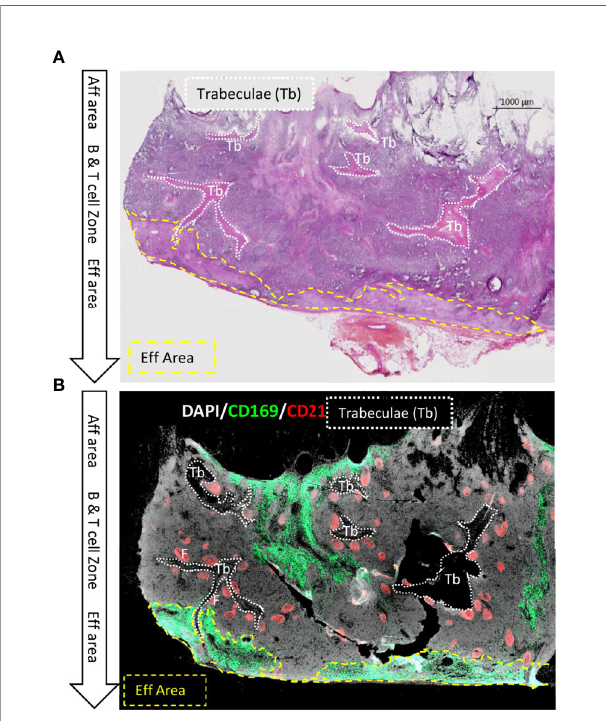
FIGURE 1 | Main features of swine inverted LN in HES and B cells/macrophage immuno fl uorescent staining on consecutive sections. Consecutive 10 µm thick sections of a tracheobronchial LN were stained using (A) HES or (B) anti-CD21 (red) and anti-CD169 (green) antibodies and DAPI nuclear staining. Dotted white lines delimited Trabeculae (Tb), dashed yellow lines delimited the efferent area (Eff Area). F: B cell Follicle. Aff area, Afferent area; Eff area, Efferent area. Whole LN pictures are individual images from 10x objective acquisitions, scale bar 1000 µm. Images are representative of 3 LN from different